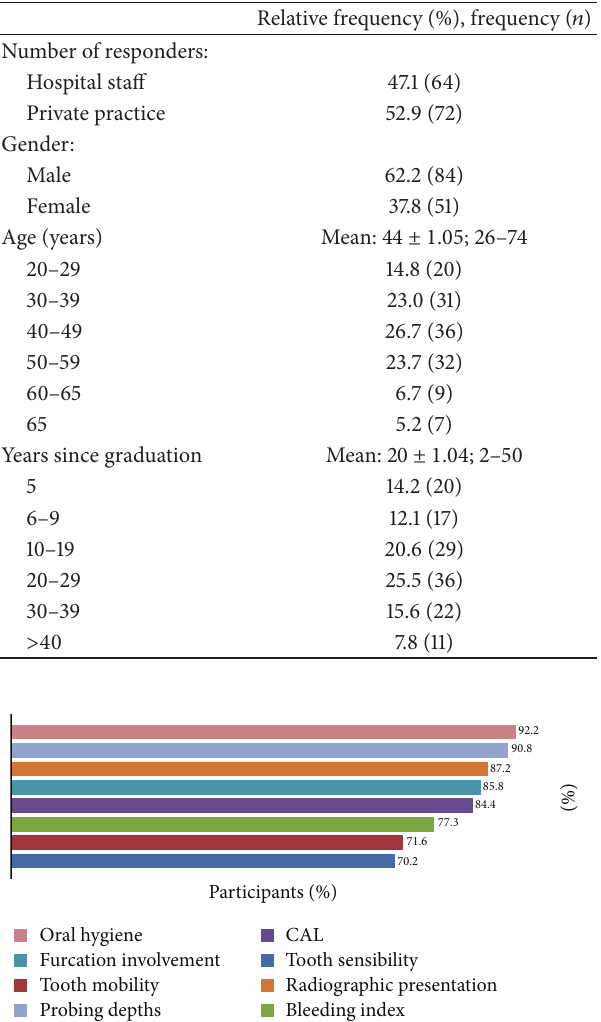
Table 1: General characteristics of the participants.